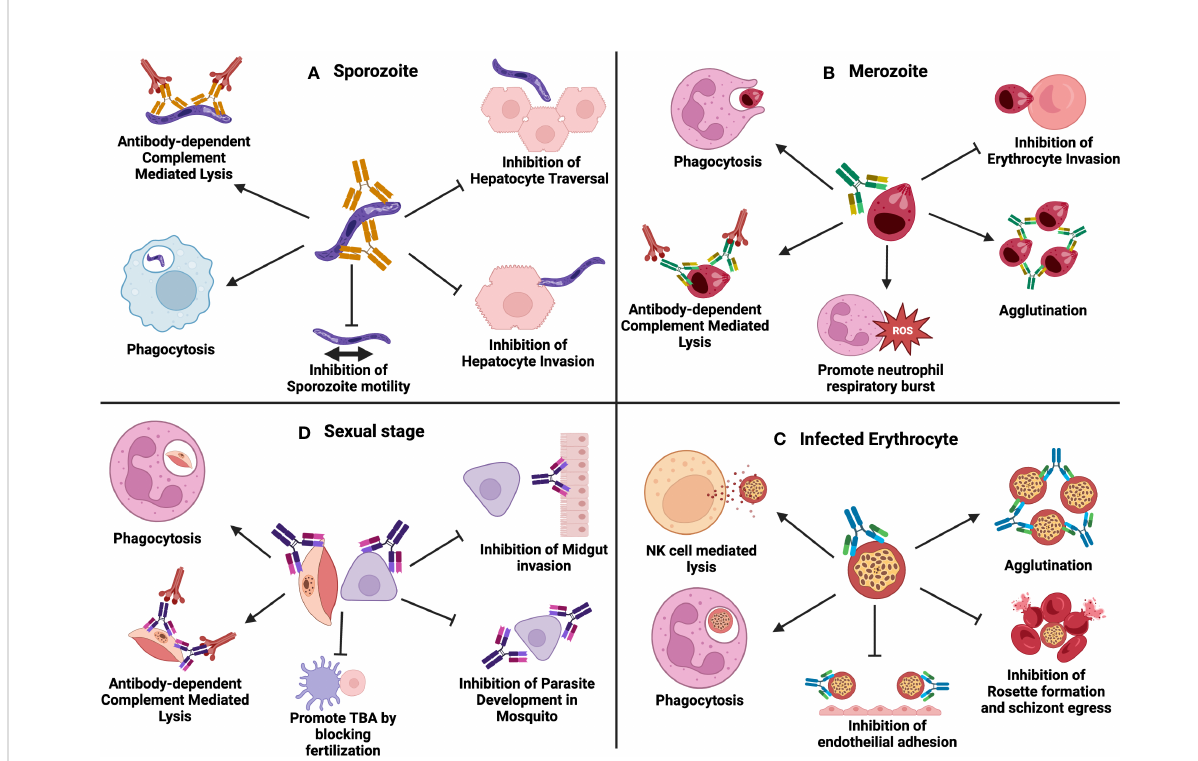
FIGURE 2 Multiple antibody effector functions involved in immunity to malaria: (A) Antibodies to sporozoites can function through phagocytosis, complement activation, inhibition of sporozoite motility, inhibition of hepatocyte traversal and inhibition of hepatocyte invasion. (B) Antibodies to merozoites can function through phagocytosis, complement activation, promoting neutrophil respiratory burst, agglutination and inhibition of erythrocyte invasion. (C) Antibodies against infected erythrocytes function through phagocytosis, NK-cell mediated antibody-dependent cellular cytotoxicity (ADCC), agglutination, inhibition of endothelial invasion, inhibition of rosette formation, and schizont egress. (D) Antibodies during parasite sexual stages function through phagocytosis, complement activation, promoting TBA by blocking fertilization, inhibition of midgut invasion and inhibition of parasite development in the mosquito. Created with